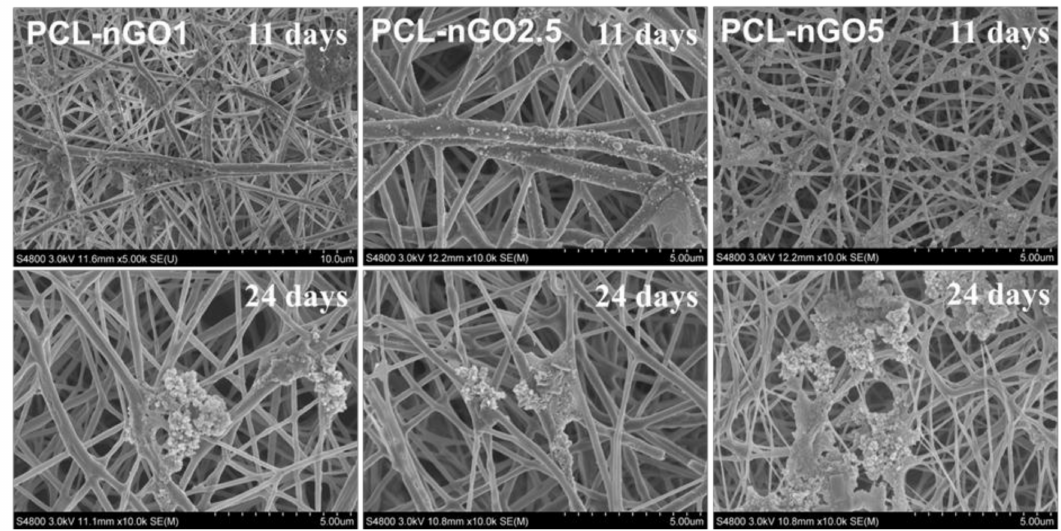
Figure 10. SEM images of PCL-nGO1, PCL-nGO2.5, and PCL-nGO5 fibers after 11 and 24 days of mineralization in